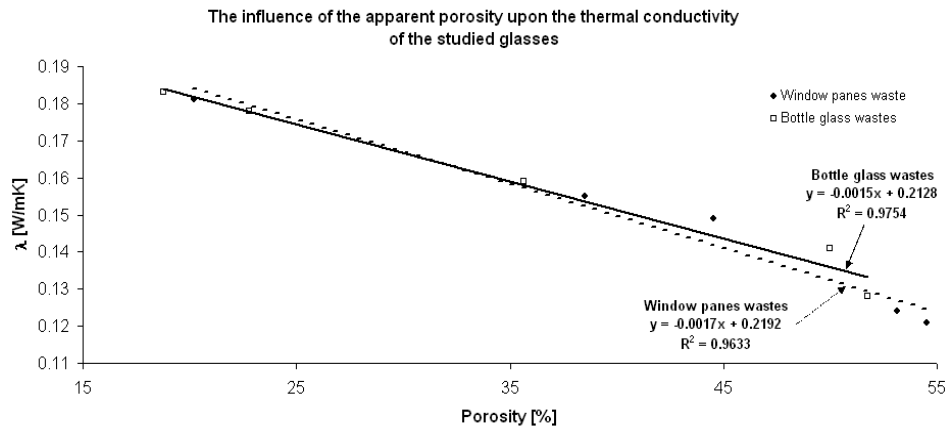
Figure 6. The influence of apparent porosity upon the insulating properties of the glass